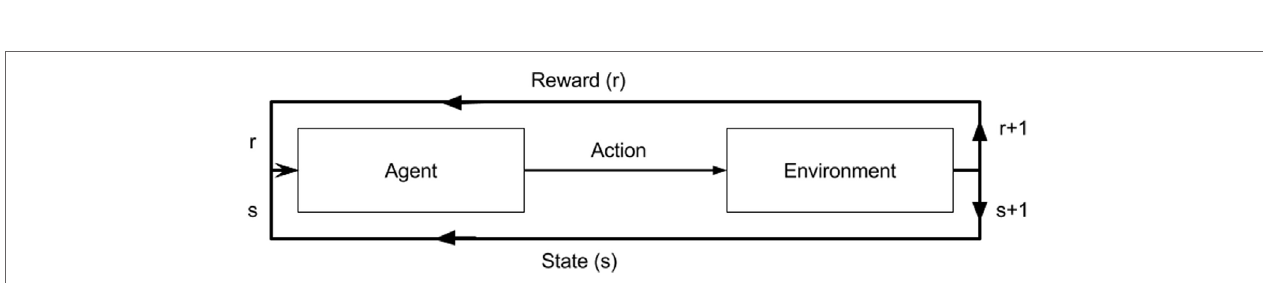
FigUre 1 | Visual illustration of a sample nodule and non-nodule structure in the lung nodule analysis dataset. Frame (a) is a nodule. Frames (B–D) are non-